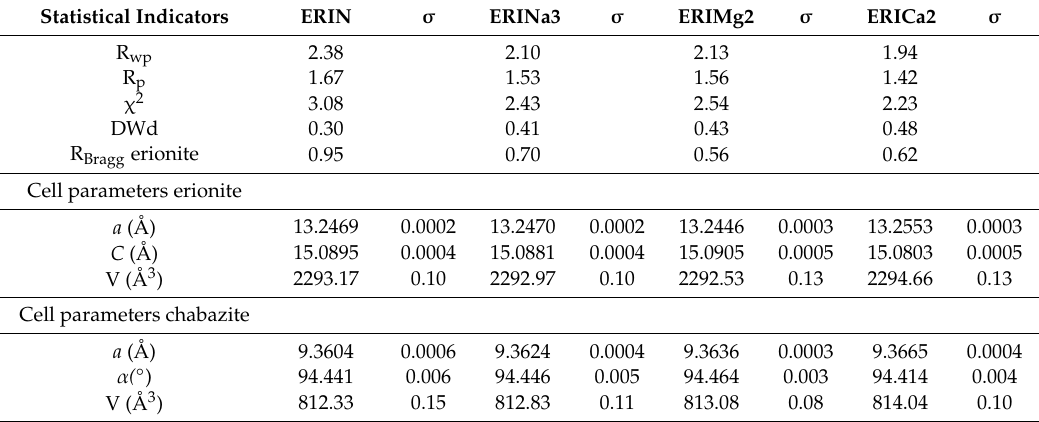
Table 3. Miscellaneous data of the Rietveld refinements including agreement indices, cell parameters of erionite and coexisting chabazite, site scattering (s.s.) at both extra framework (EF) and H 2 O sites. Statistical indicators as defined in Young (1993)